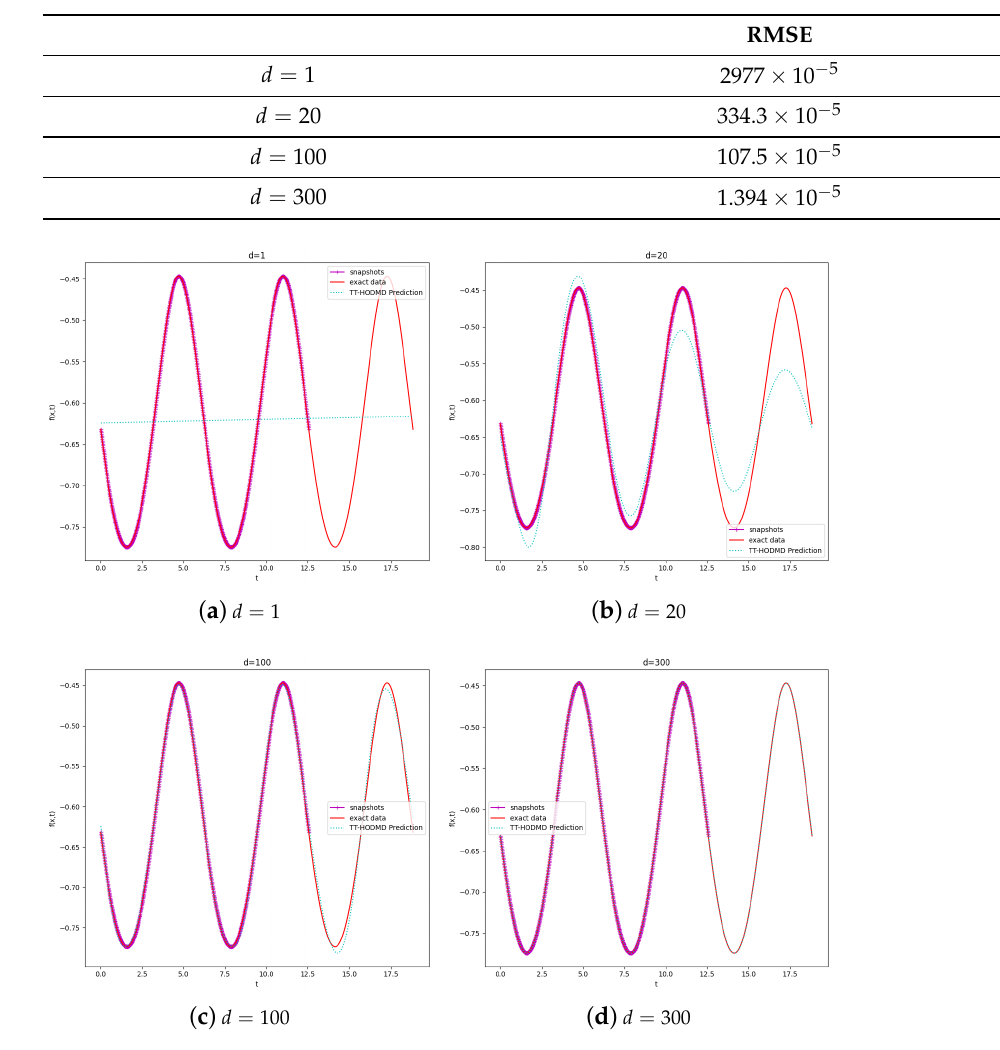
Figure 5. Prediction with different d